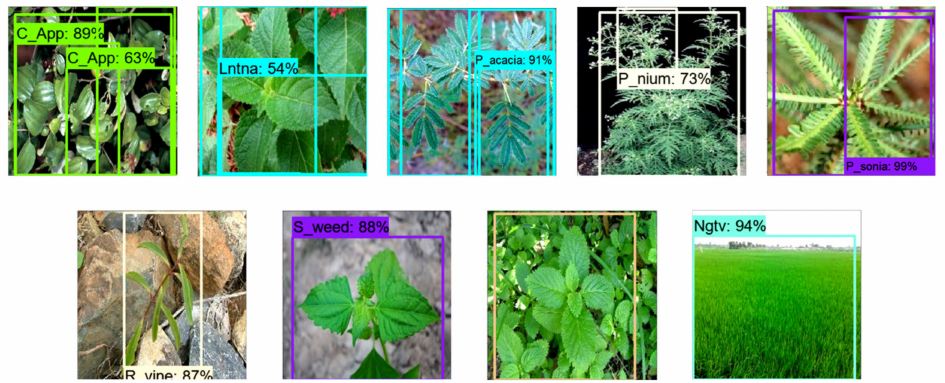
Figure 16. A sample of each class by externally generated